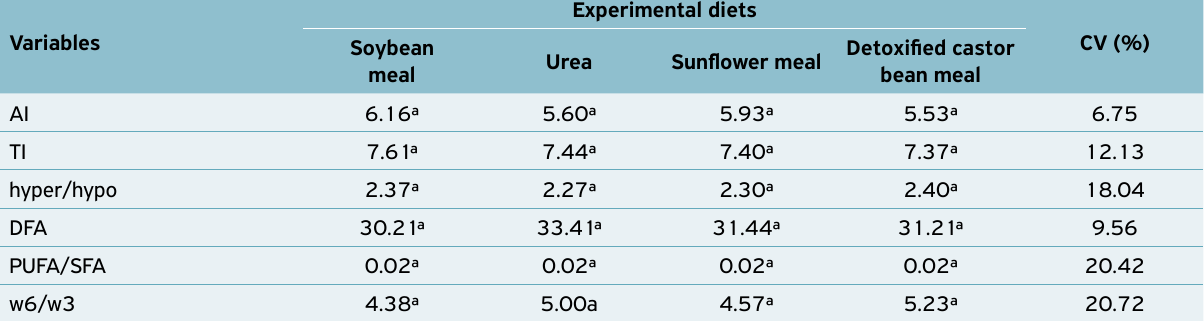
Table 5. Atherogenicity index (AI), thrombogenicity index (TI), hyper/hypocholesterolemic ratio, desirable fatty acids (DFA) and ratio of polyunsaturated/saturated fatty acids ratio (PUFA/SFA) in Minas fresh cheese (mg/g fat) made with milk from F1 Holstein/ Zebu cows fed diets containing different sources of nitrogen compounds, with respective coefficients of variation